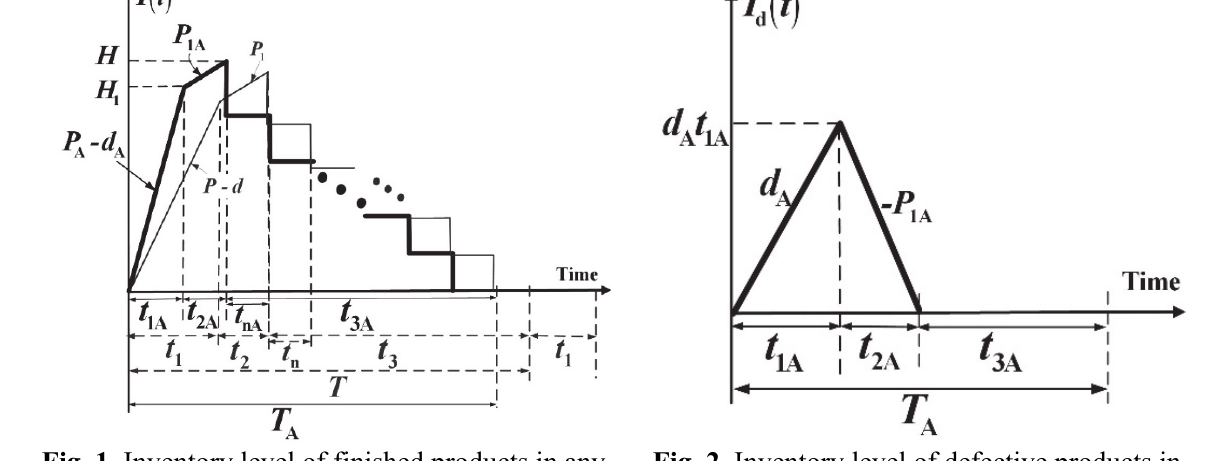
Fig. 2. Inventory level of defective products in the proposed EMQ-based system